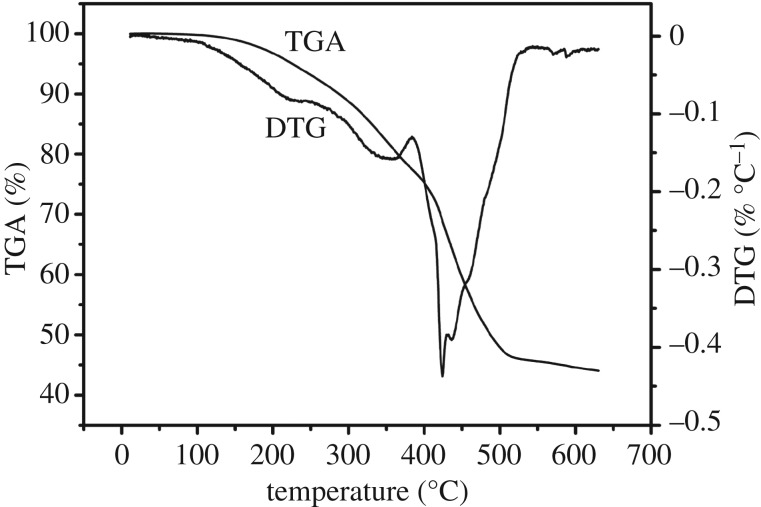
Thermogravimetric/differential analysis (TGA/DTG) of SAPs.